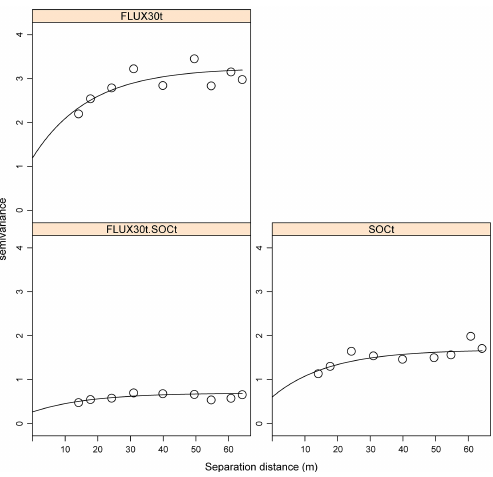
Figure 7. Direct and cross-semivariograms (open circles, detrend- ing the influence of chamber placement position for cokriging) and the best-fitted linear model of the co-regionalization (solid lines) of the normal logit-transformed N 2 O fluxes (FLUX30t) (no dimen- sion) and the normal SOC (SOCt, no dimension). The linear model of co-regionalization was characterized by using the same range and different sills for its component